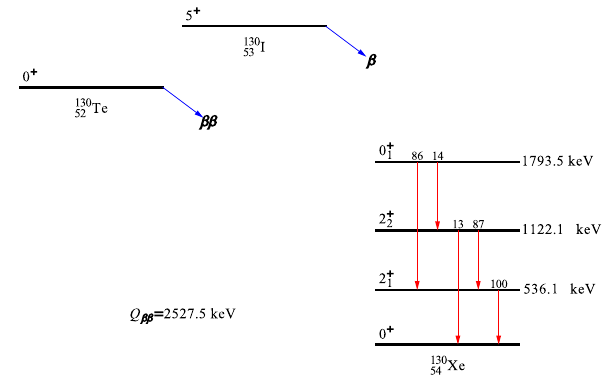
Fig. 1 Decay scheme of 130 Te showing the energy levels and the branching ratios for the γ rays